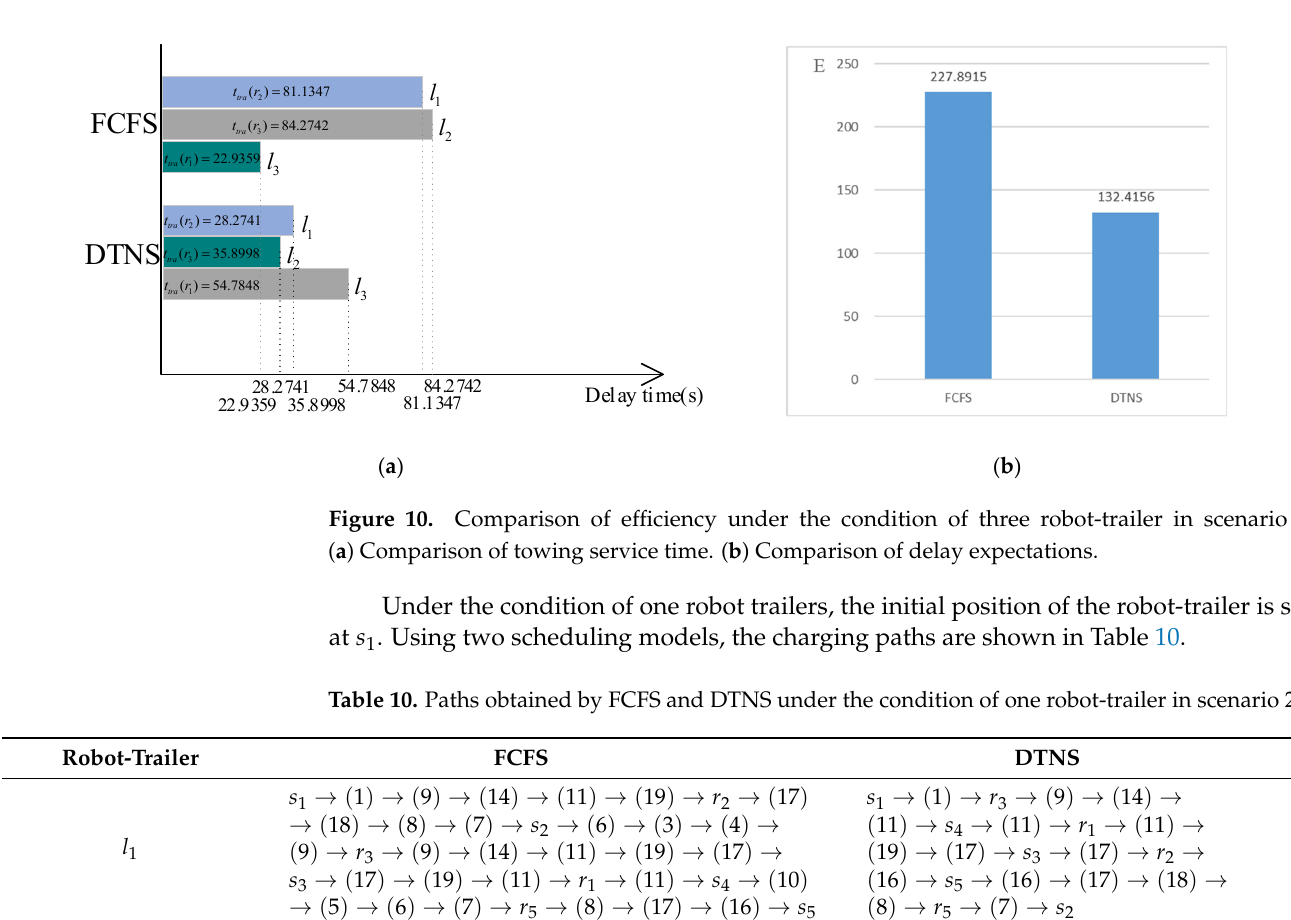
Table 10. Paths obtained by FCFS and DTNS under the condition of one robot-trailer in scenario 2. Robot-Trailer